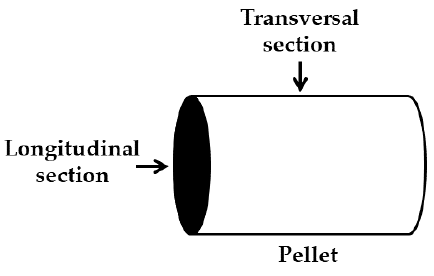
Figure 2. Transversal and longitudinal sections of the samples.